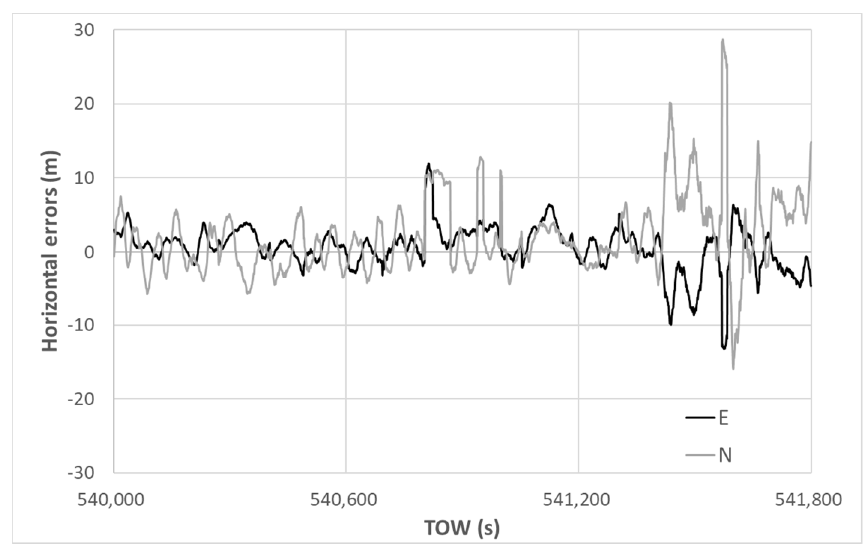
Figure 17 . DGNSS horizontal errors.